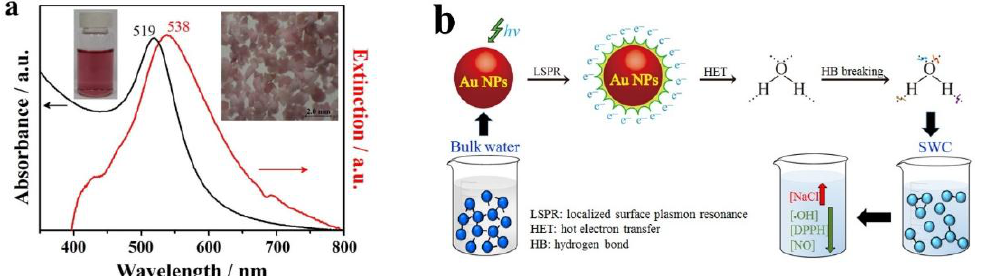
Figure 1. Preparation of plasmon-activated water (PAW) and its creation mechanism and main properties. ( a ) UV–vis absorption spectrum of AuNPs in solution (black line) and UV–vis extinction spectrum of AuNP-adsorbed ceramic particles (red line). ( b ) Schematics of mechanism of the preparation of SWC (also called PAW) with reduced hydrogen bonding based on LSPR effect on AuNPs under resonant illumination and distinct property and antioxidative activity of prepared SWCs. The formation of SWCs occurred at the resonantly illuminated Au interface. In storage and in the absence of AuNPs, both the forward reaction from bulk water to AuNT water and the corresponding reverse reaction from AuNT water to bulk water are slow, due to the huge activation energies required for both reactions. Therefore, the prepared SWC is temporarily trapped in a relatively stable state in an activation energy valley, in which it can persist in liquid water without reverting to normal hydrogen-bonding patterns observed in bulk water. The saturated solubility of NaCl in SWCs can be significantly increased. SWC itself can effectively scavenge free hydroxyl and DPPH radicals. Also, SWCs effectively reduces NO release from LPS-induced inflammatory cells [23].